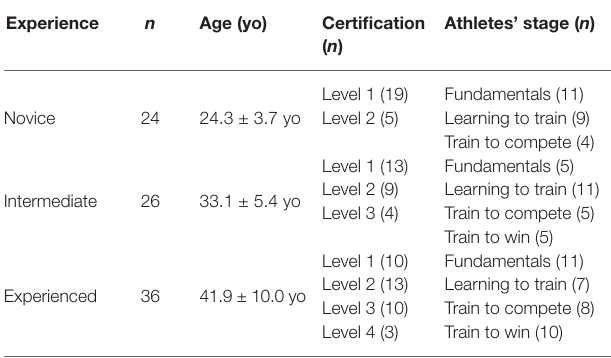
TABLE 1 | Basic characteristics of the swimming coaches by level of